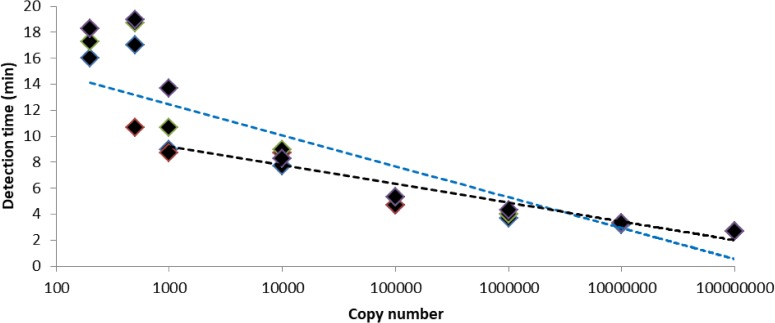
RT-RPA performance.Detection times of four replicates of serially diluted in vitro transcribed rabies virus (CVS-11) RNA. Correlation between detection time and copy number is indicated by semi-logarithmic regression lines of all dilutions evaluated i.e. 200−108 copies (blue dotted line, R2 = 0.82) and where the two lowest dilutions were excluded i.e. 103−108 copies (black dotted line, R2 = 0.93).